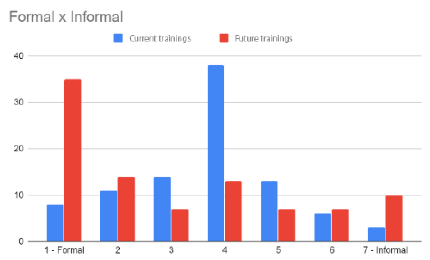
Figure 4. Vision of electricians and instructors about current and fu- ture trainings: formal x informal.